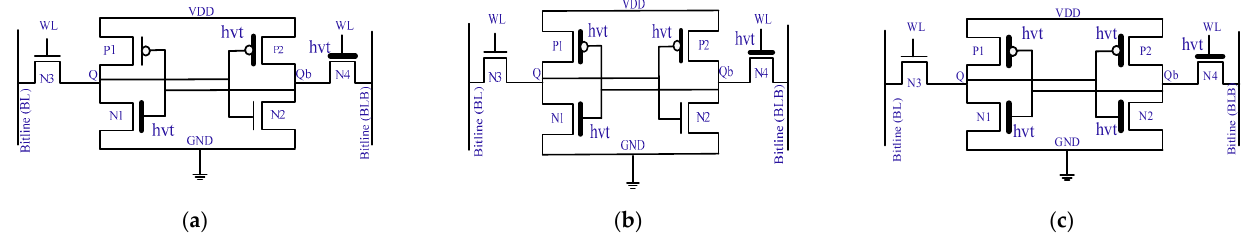
Figure 9. Asymmetrical 6T SRAM cells for leakage reduction using preferential state and multi- threshold voltage [43]. ( a ) Asymmetric: ‘1’ as preferential state; ( b ) asymmetric: ‘0’ as preferential state; ( c ) asymmetric leakage optimization.